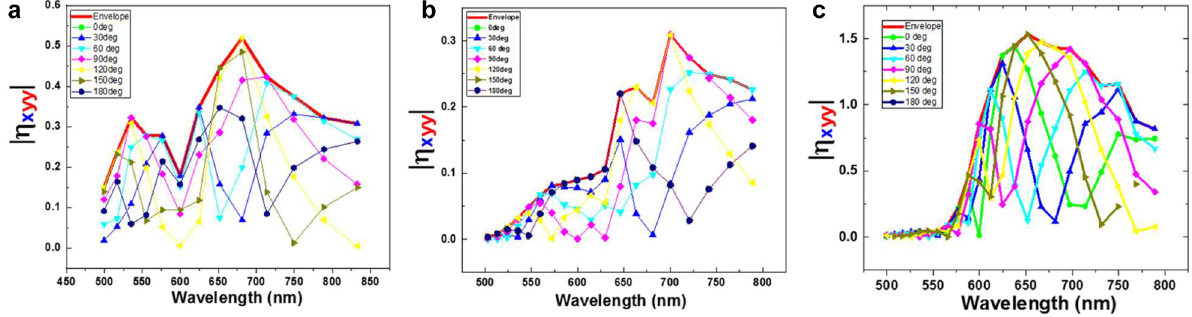
Figure 9: (a) Relative phase dependence of nonlinear coefficient as a function of wavelength for (a) SRR Au-DRM. (b) Heptagonal Au-DRM. (c) Triangular Au-DRM. The thick line in each graph corresponds to the upper envelope of the phase dependence of nonlinear coefficient as a function of